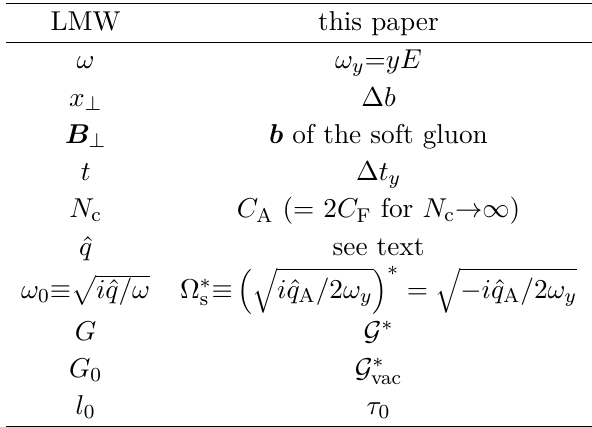
Table 1 . Translations between the notation of LMW [9] and this